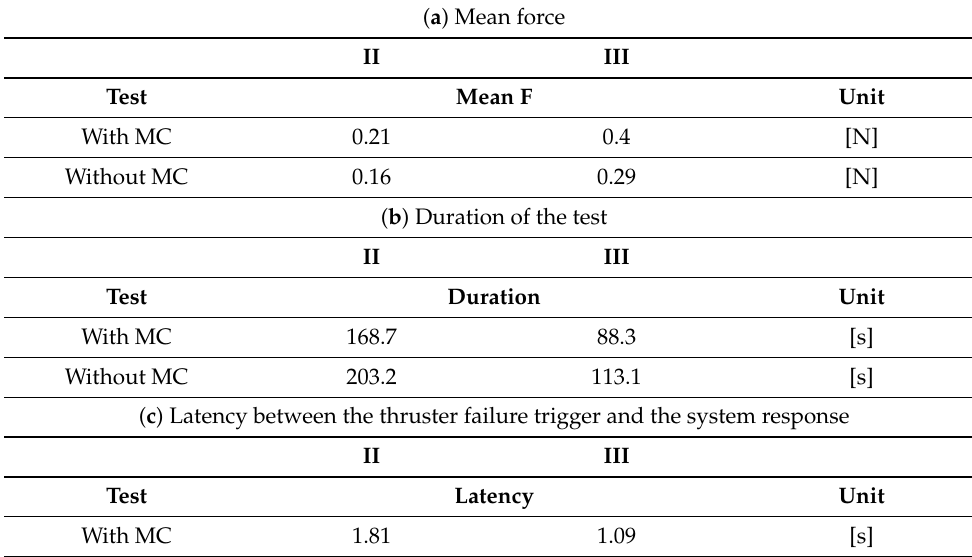
Table 5. Numerical comparison of the experiments performed with and without the metacontroller (MC). II represent the test with the failure of T 0 . III represent the test with the failure of T 1